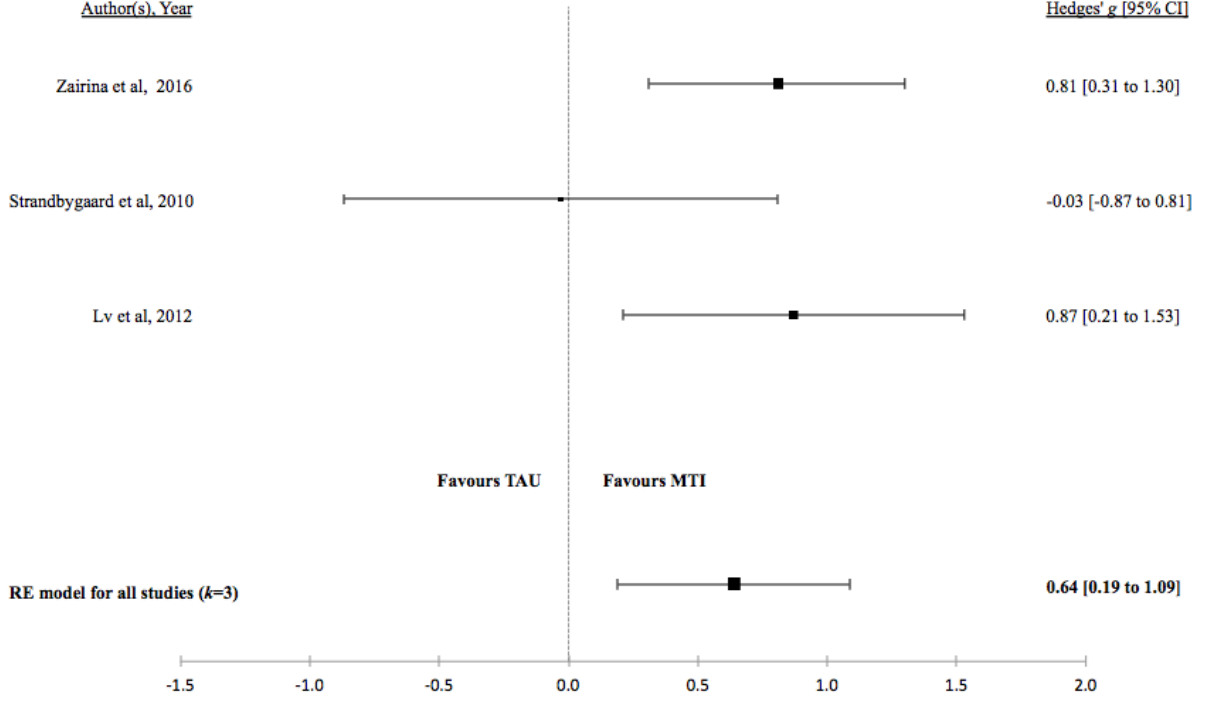
Figure 13. Forest plot of the standardized mean difference in quality of life between MTI and standard treatment. MTI: mobile technology intervention.